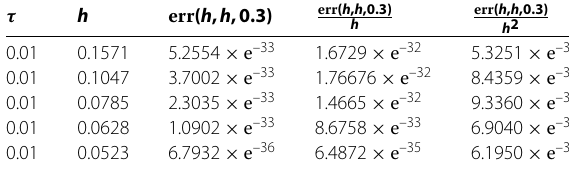
Table 2 L ∞ -errors for different space steps at t =